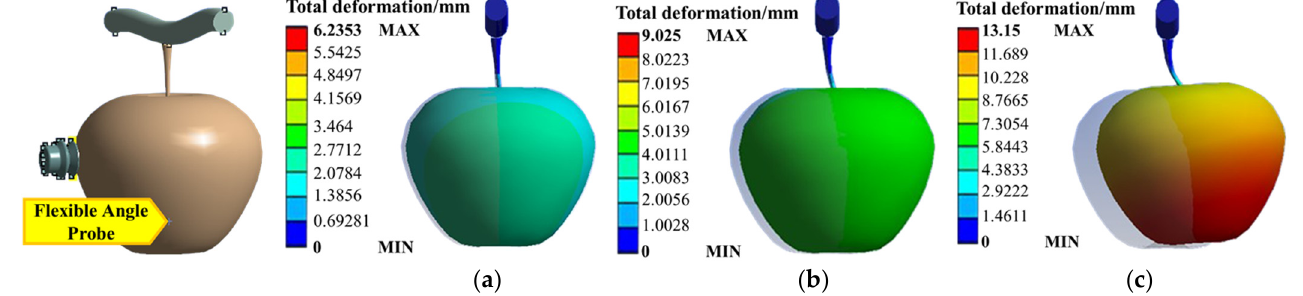
Figure 23. Three suction cup layout designs: ( a ) 120° suction cup layout; ( b ) 90° suction cup layout; ( c ) 72° suction cup layout.